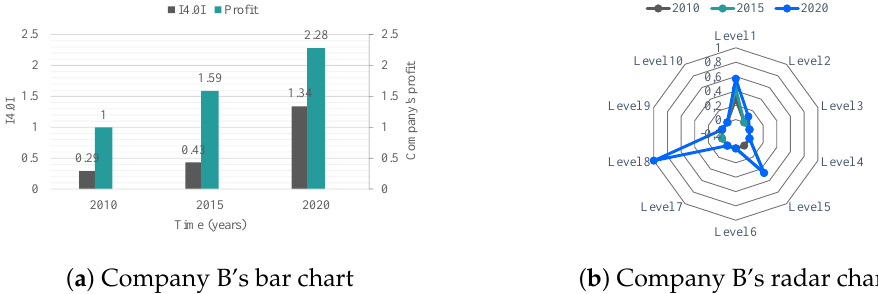
Figure 6. Company B’s graphics generated by the answers obtained by the questionnaire applied.